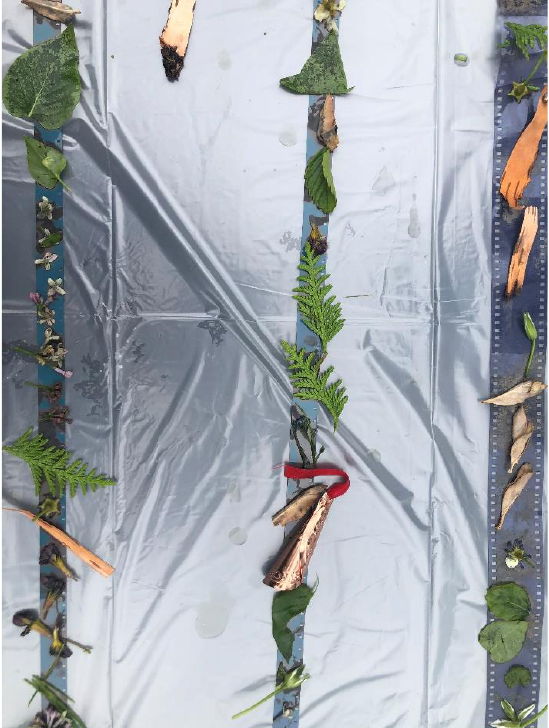
Figure 2. The Odeimin Runners Club lay materials on film, producing phytograms. What is phytography? Many plants contain polyphenols, molecular packets like